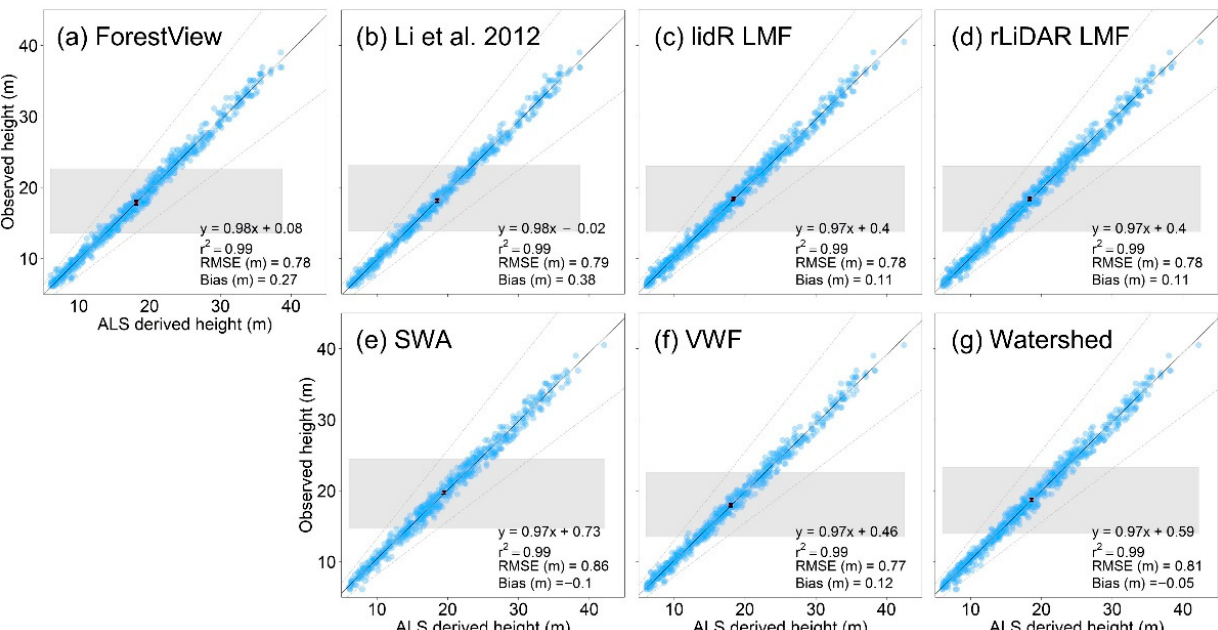
the ±25% region of equivalence for the intercept. The ALS-derived and cruised heights are equiva- lent to the felled height when the vertical red bar is completely within the grey polygon. The grey dashed lines represent the ±25% region of equivalence for the slope. If the vertical black bar is within the grey dashed lines, then the regression slope is significantly similar to 1. The solid black line represents the best-fit linear regression model. The method shown in (b) refers to [19].